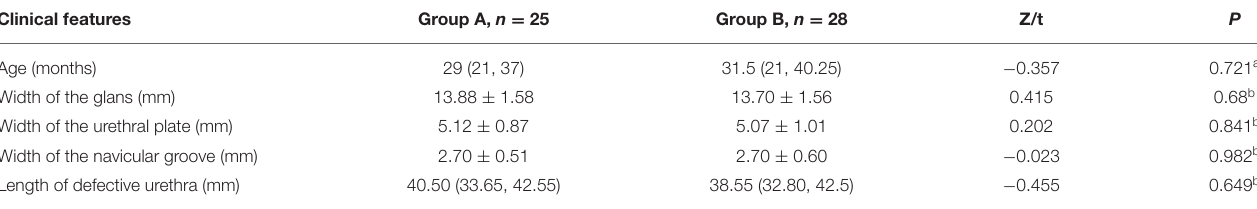
TABLE 1 | Comparison of clinical measurement data between two groups. Clinical features